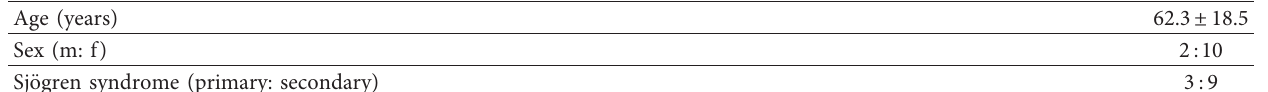
Table 1: Demographic data of the study